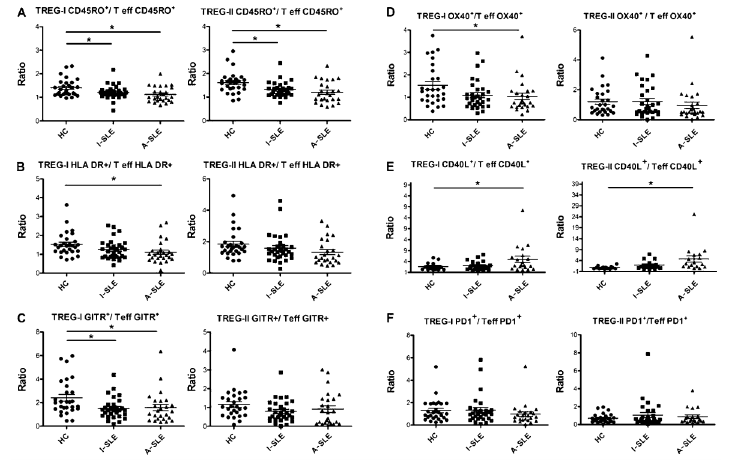
Figure 6. Ratio of TREG-I (CD25 + CD127 Ø/low FoxP3 + ) or TREG-II (CD25 high CD127 Ø/low FoxP3 + ) cells to effector T cells expressing CD45RO ( A ), HLA-DR ( B ), GITR ( C ), OX40 ( D ), CD40L ( E ), and PD1 ( F ) in patients with active SLE (A-SLE), inactive SLE (I-SLE), and healthy controls (HC). Horizontal bars indicate means and standard deviation, respectively. Teff: effector T cells. *P , 0.05 (Kruskall-Wallis